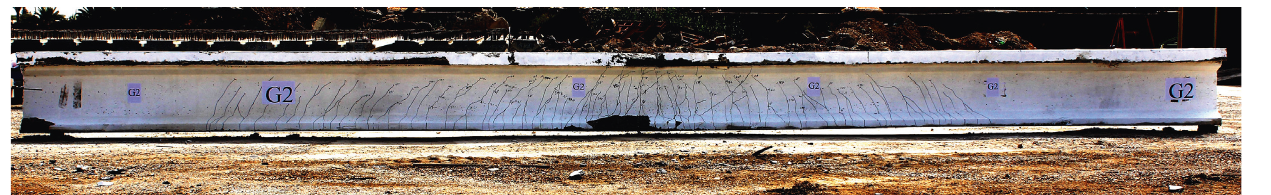
Figure 14: Crack pattern of girder G2 after testing.